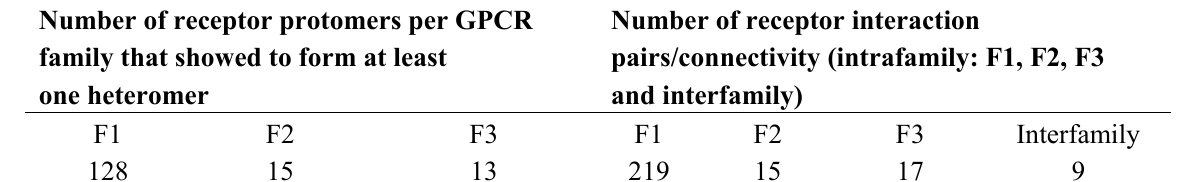
Table 1. General properties of the receptor–receptor heteromer interaction network. F1, G-protein coupled receptor 1 (Class A or rhodopsin-like); F2, G protein-coupled receptor 2 (Class B or Secretin receptor family); F3, G protein-coupled receptor 3 (Class C or Metabotropic